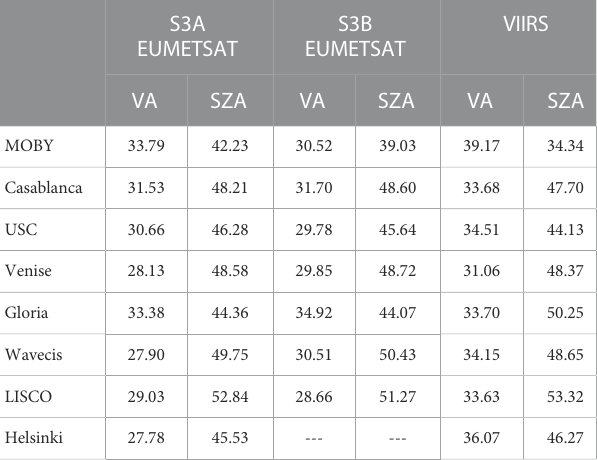
TABLE 3 Viewing (VA) and solar zenith (SZA) angles (in degrees) at the areas of study.